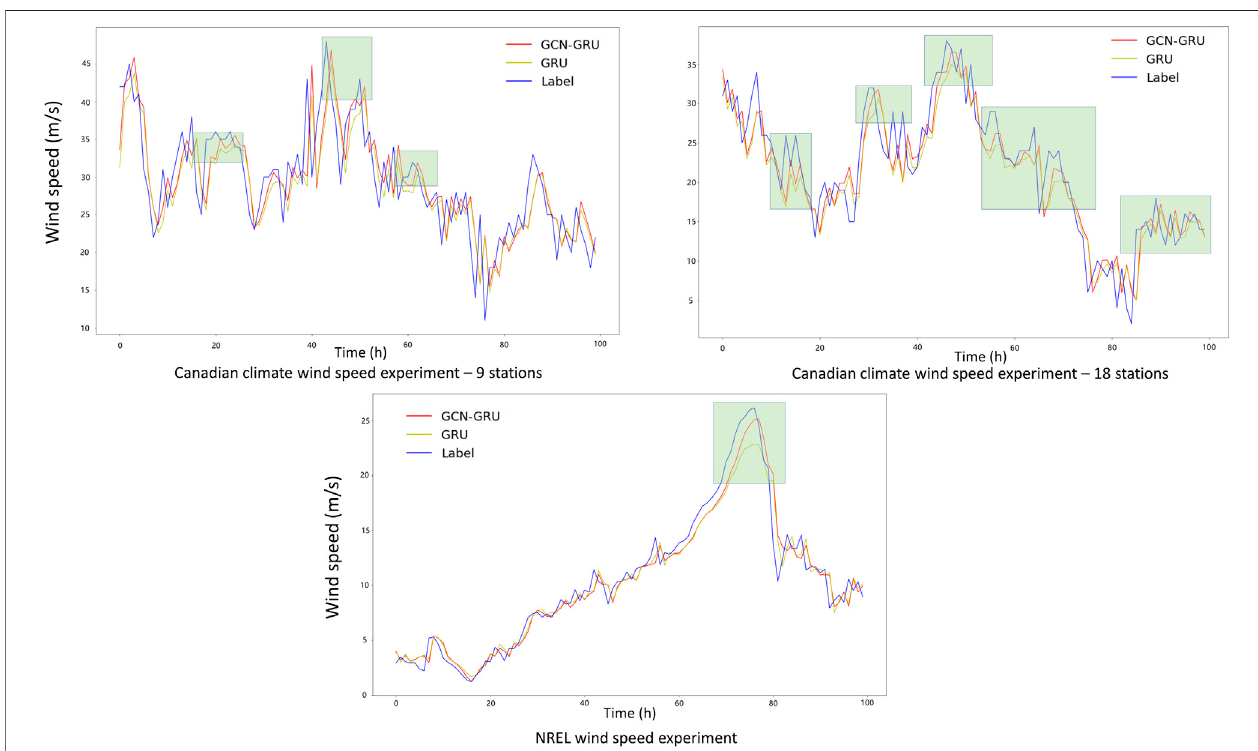
FIGURE4| ComparisonofthreewindspeedpredictionexperimentsbetweenGCN-GRUandGRU;thelightgreenareasarewhereGCN-GRU ’ spredictioncurves closer to the real curve, namely, GCN-GRU performs better than GRU in one-step wind speed prediction.